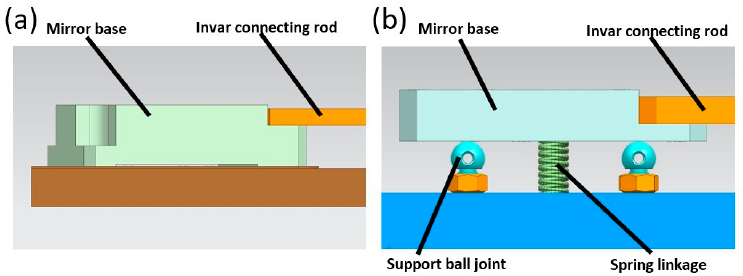
Figure 13. ( a ) Fixed support model; ( b ) Rolling support model.